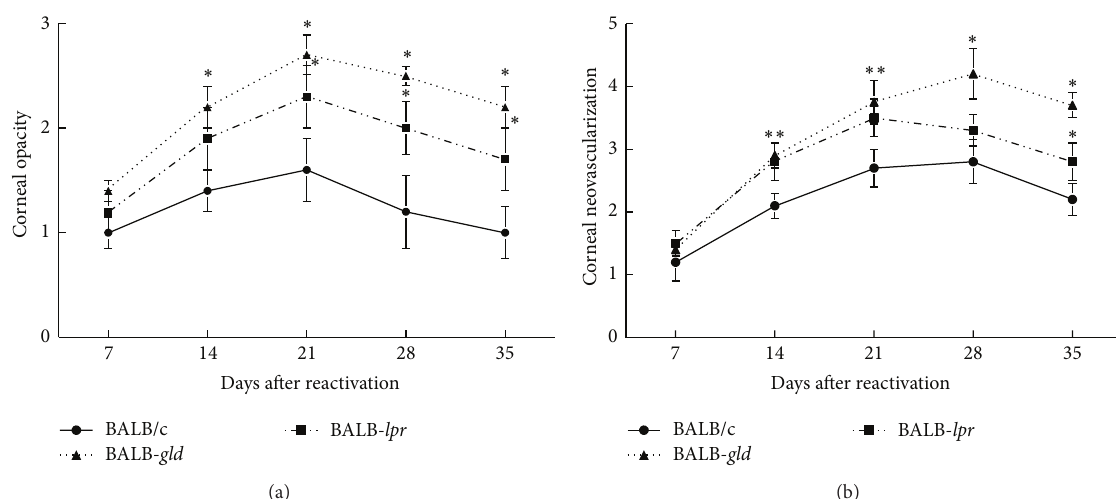
Figure 2: Defective expression of both FasL and to a lesser extent Fas results in increased recurrent HSK following UV-reactivation of a latent infection with HSV-1, McKrae strain. Eyes of BALB/c wild-type ( 𝑛 = 20 ), BALB- lpr ( 𝑛 = 20 ), and BALB- gld ( 𝑛 = 20 ) mice were infected with 10 6 pfu of HSV-1, McKrae strain. Six weeks following infection mice were irradiated with UV-B to reactivate the latent infection. Corneal opacity (a) and corneal neovascularization (b) were measured and compared between these strains of mice. ∗ Significant virus- induced corneal opacity was observed for BALB- gld at days 14–28 timepoints when compared to BALB/ccontrols ( 𝑃 < 0.01 –0.001). BALB- lpr mice displayed significantly more opacity than did BALB/c controls at days 21–35 ( 𝑃 < 0.05 –0.01). BALB- gld displayed significantly greater neovascularization at days 14–35 ( 𝑃 < 0.05 –0.001) and BALB- lpr mice had greater neovascularization at days 14, 21, and 35 ( 𝑃 < 0.05 –0.01) than did BALB/c controls.